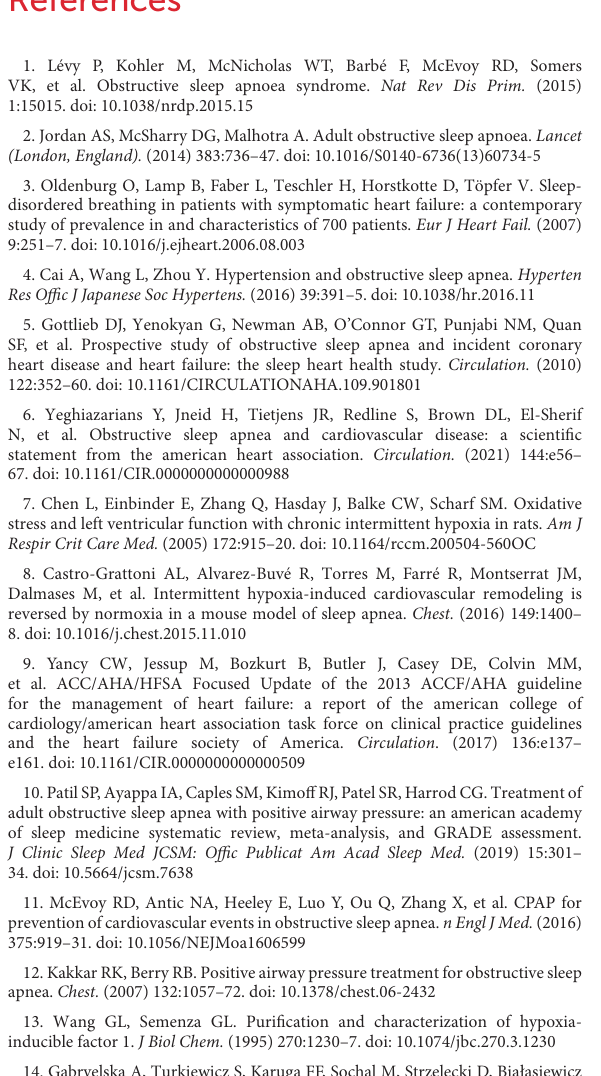
SUPPLEMENTARYFIGURE2 Flow chart of the experimental process. SUPPLEMENTARYFIGURE3 Left: CIH exposure after TAC surgery, tail vein injection of AAV9-PHD3 on week 1, and PHD3 protein expression was measured in cardiac tissue on week 6. Right: PHD3 protein expression in heart tissue after 4 weeks of AAV9-PHD3 tail vein injection under normoxia. SUPPLEMENTARYTABLE1 Primer sequences used for